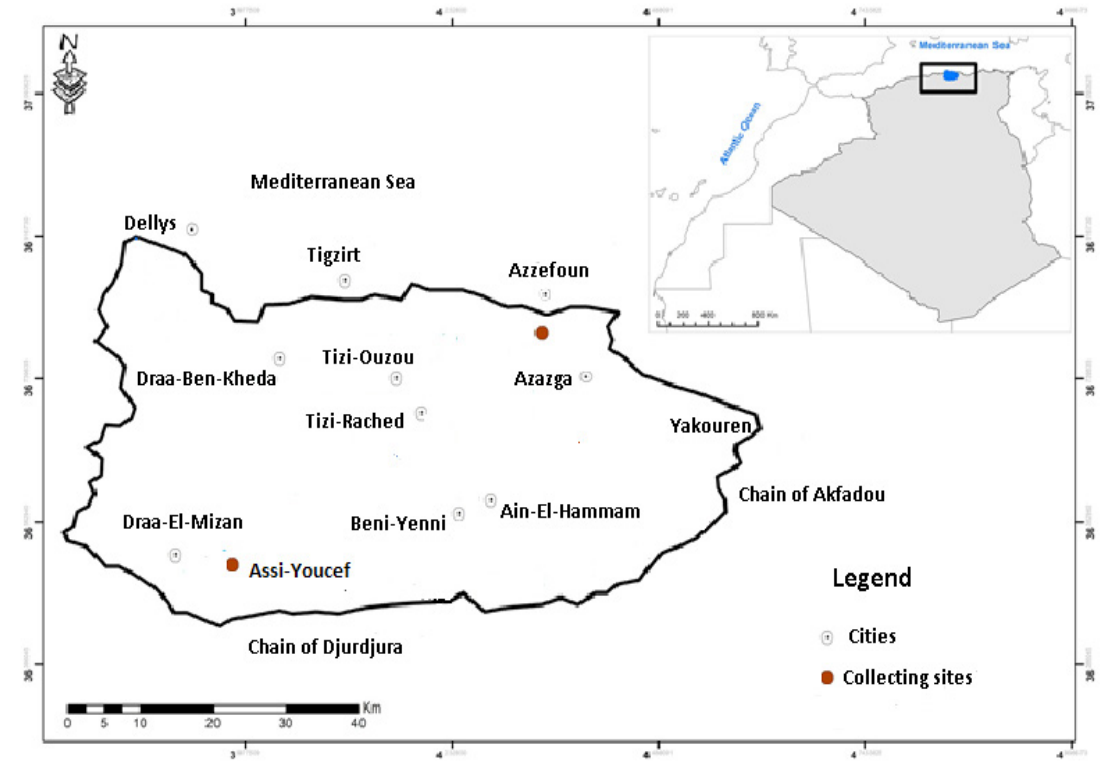
Fig 1. Location of the study